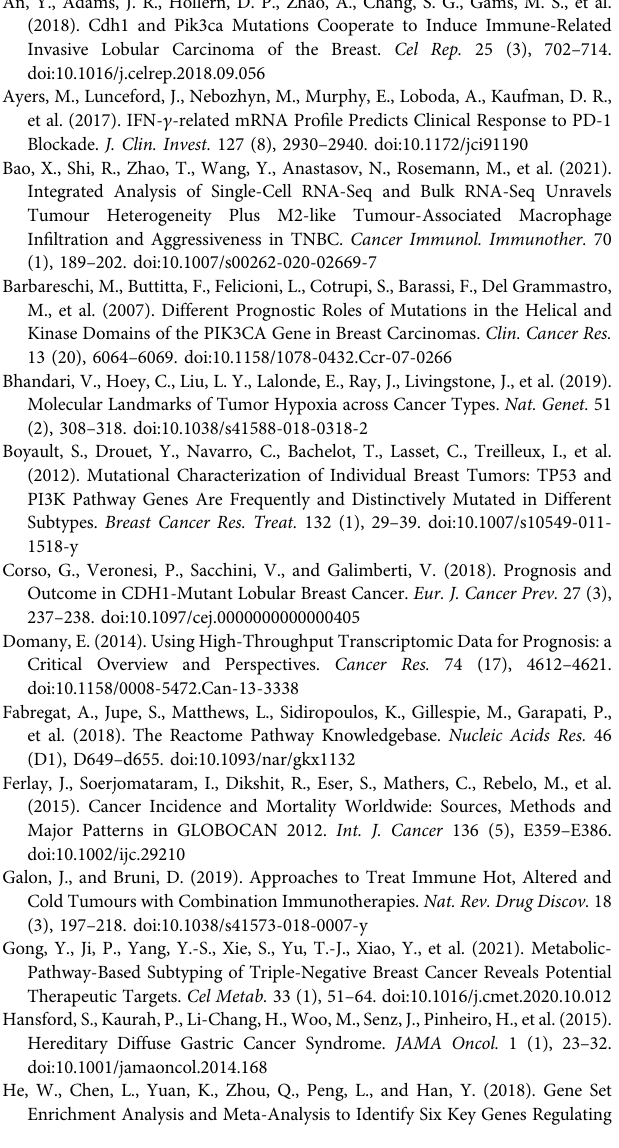
Supplementary Figure S3 | KM curves show the prognostic performance of the classi fi er in different age level and tumor stage level of all included cohorts. Only cohorts with available clinical information are shown in the plot. Supplementary Figure S4 | Comparison of tumor mutation burden between the G1 and G2 subgroups. SupplementaryFigureS5 |Sankeyplotshowsthedistribution ofgroup2(G2)and group 1 (G1) in different clinicopathological and genetic subgroups. Supplementary Figure S6 | Gene Set Enrichment Analysis (GSEA) analysis shows the differences between group 2 (G2) and group 1 (G1) at Hallmark, (Kyoto Encyclopedia of Genes and Genomes) KEGG, and Reactome pathway aspects. Supplementary Figure S7 | CIBERSORT analysis shows the distributions of 22 tumor in fi ltrated immune cells in each breast cancer